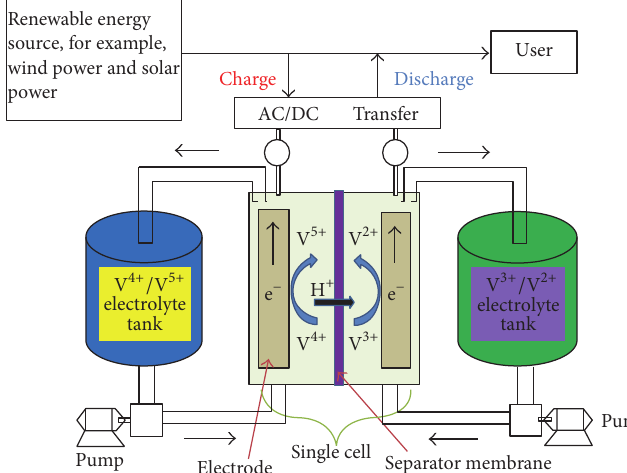
Figure 1: Schematic of a vanadium redox flow